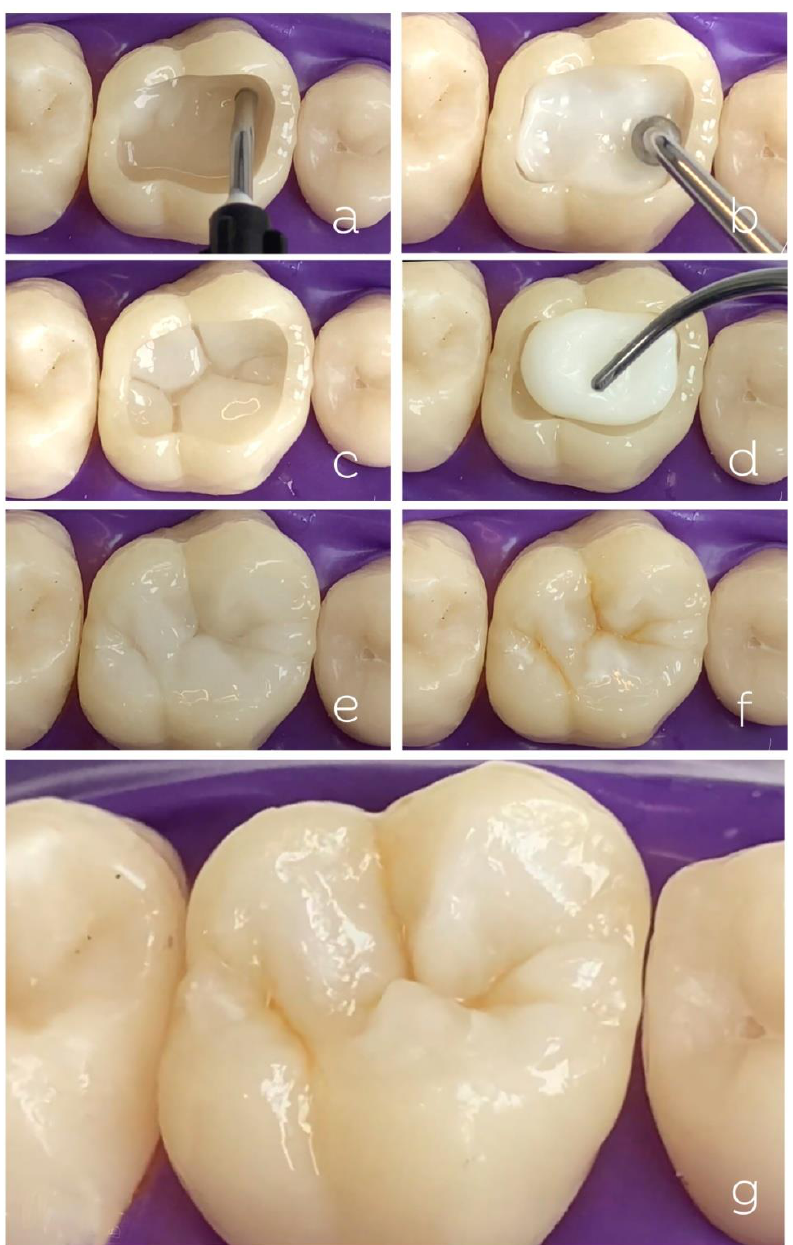
Figure 9. Class I restoration using a shade-matching resin composite. Filling irregular areas and rounding internal angles with shade-matching flowable composite ( a ). Insertion of shade-matching composite to replace dentin ( b ). Aspect of the artificial dentin after occlusal mapping and design ( c ). Insertion of the same shade-matching composite for the preparation of dental enamel in a single increment ( d ). Final aspect of artificial enamel carved in single increment ( e ). Extrinsic characterization with ochre, brown tints, and dentin composite for bleached teeth emulating regions of large amount of enamel as main lobes of the inclined cuspal planes ( f ). Final aspect of the restoration ( g ).